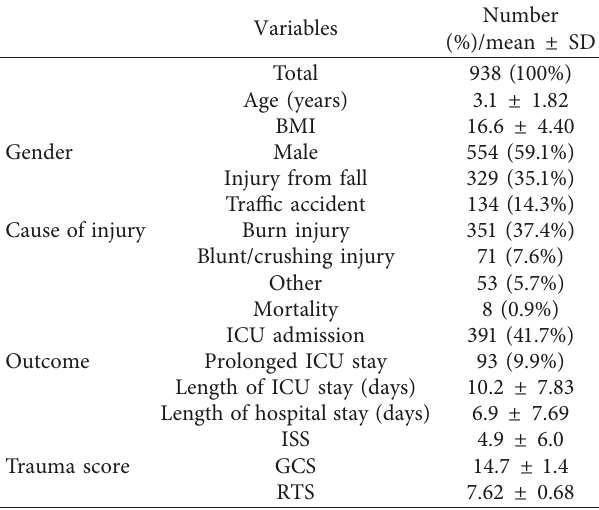
Table 1: Epidemiology of trauma patients under the age of six years admitted via the pediatric emergency